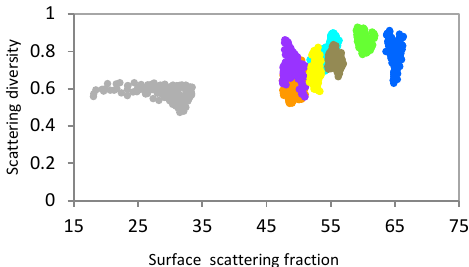
Figure.4. Scattering diversity–Surface fraction scatter plot of different types of lands.